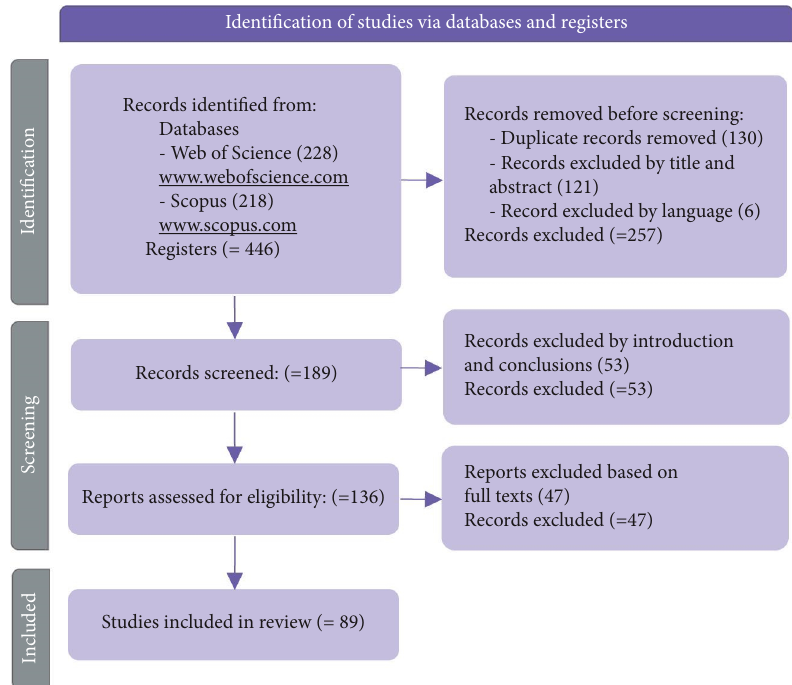
Figure 2: Screening and selection stages using the PRISMA flow diagram. +is diagram shows the different stages that are part of the methodology proposed to carry out this